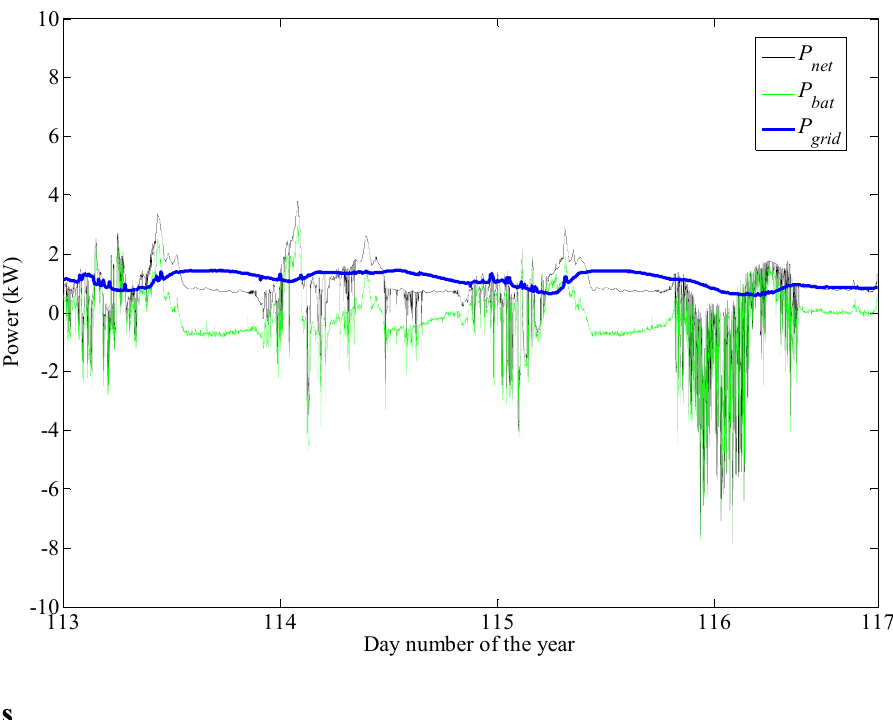
Figure 22. Net power, grid power and battery power profiles during four days of operation, measured at the